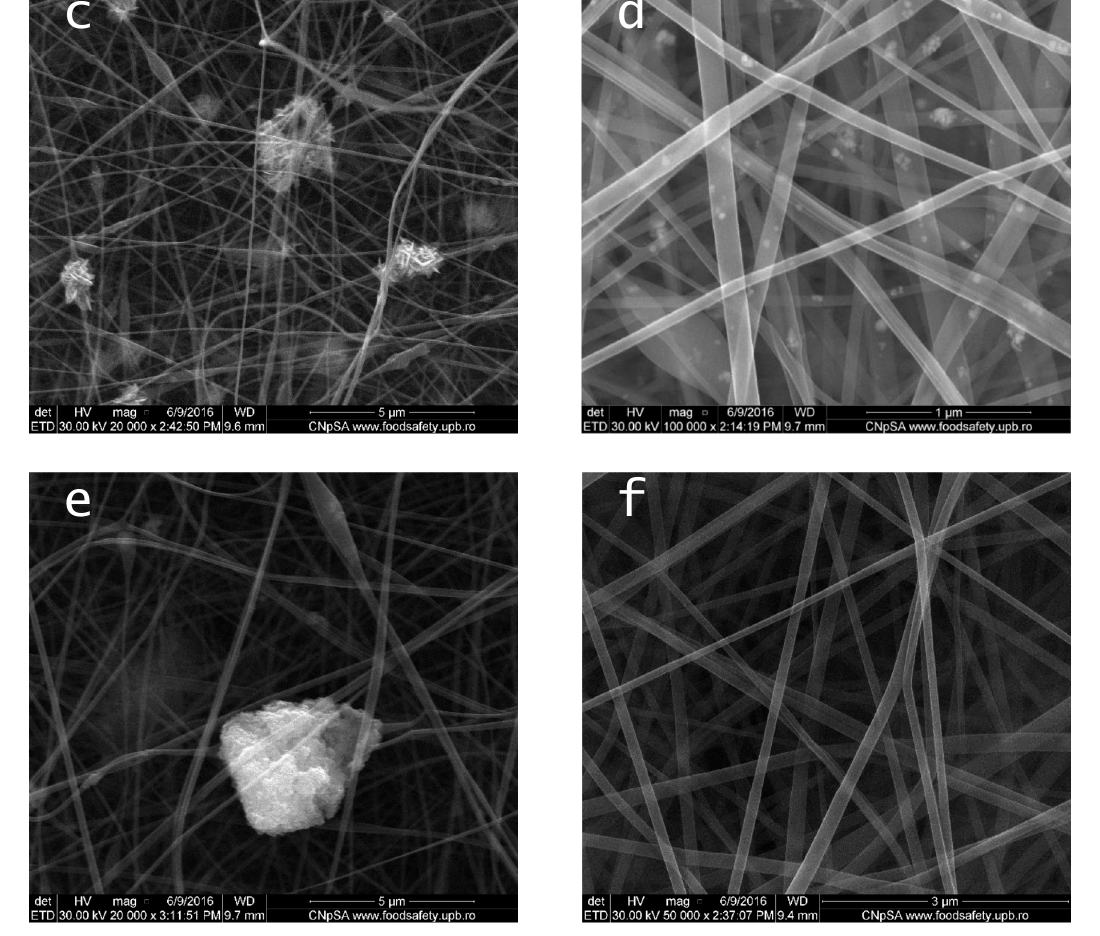
Figure 3. SEM images for composite fibres ( a ) PVA / SA / ZnO-H1, ( b ) PVA / SA / ZnO-H2, ( c ) PVA / SA / ZnO-H3 ( d ) PVA / SA / ZnO-P1, ( e ) PVA / SA / ZnO-P2, ( f ) PVA / SA.